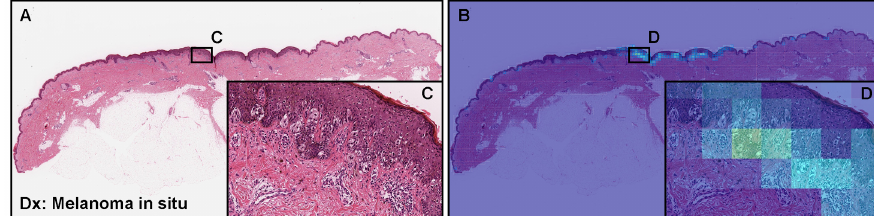
Figure 7. An example of melanoma false negative prediction using the × 20, 512 × 512 px model. According to the histopathological diagnostic (Dx) reports, ( A ) was diagnosed as melanoma in situ, which is also called stage 0 melanoma. Melanoma cells are found in the epidermis ( C ). The heatmap image ( B , D ) shows very low probabilities of melanoma but false negative predictions at the WSI level. Red indicates a high probability and blue indicates a low probability.